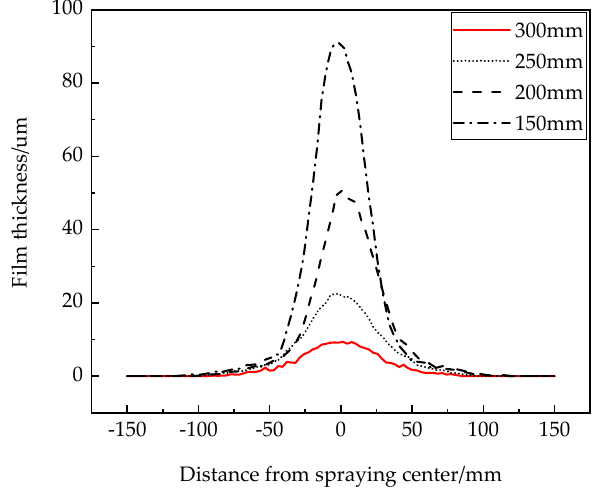
Figure 10. Cross-section curve of coating film thickness for different spray heights. With the increase in spraying height, the maximum coating thickness decreases in an approximately inverse function. The variation of the maximum film thickness is sensitive when the spraying height is between 100 mm and 150 mm, as shown in Figure 11.